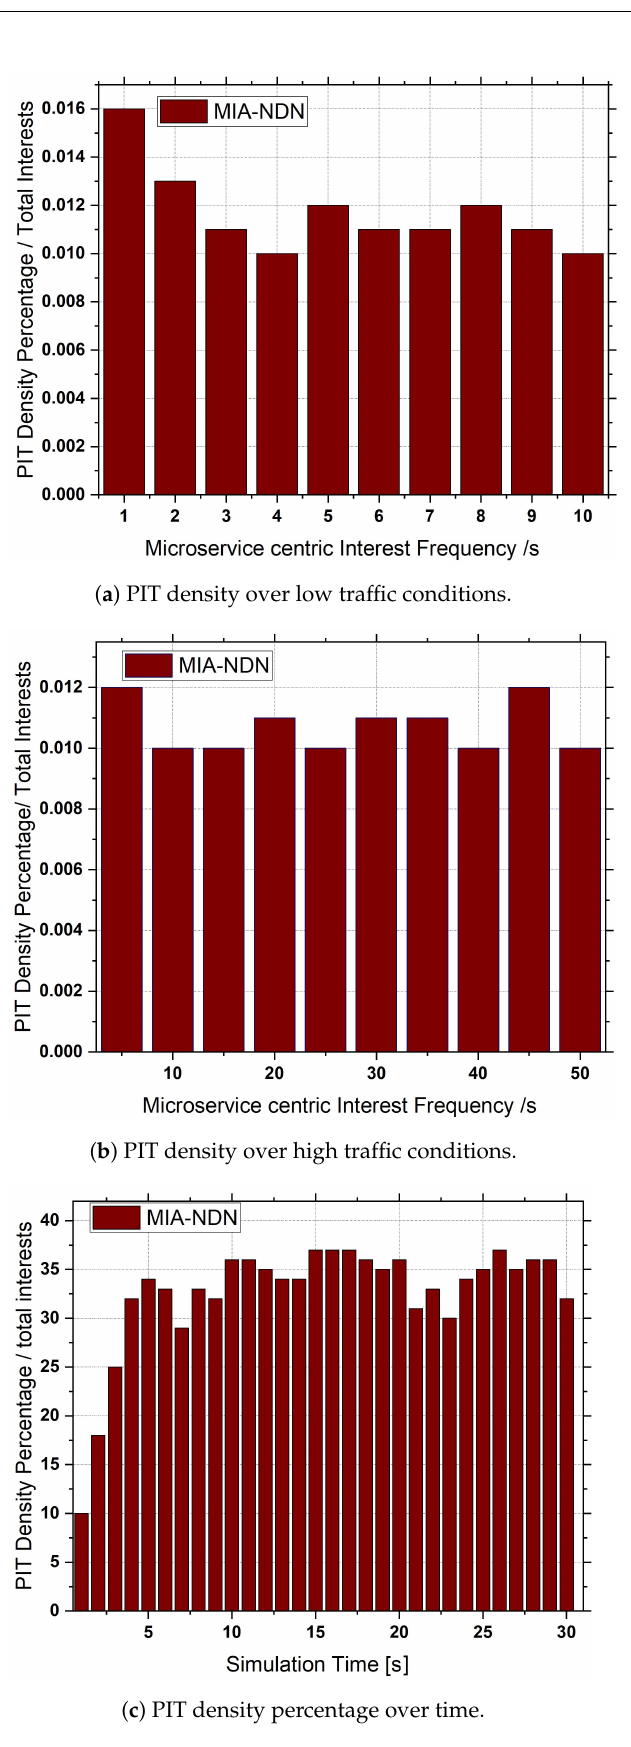
Figure 10. Microservice interest satisfaction as a function of microservice interest